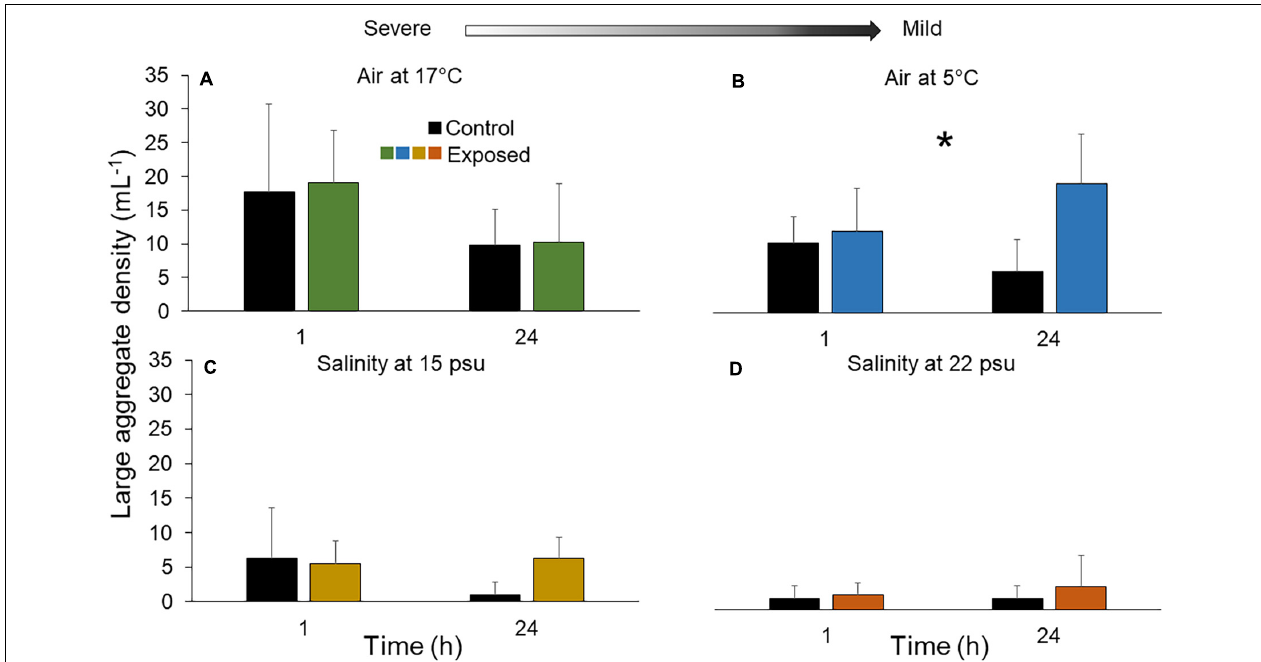
FIGURE 5 | Density of large aggregates in fluid of the Polian vesicle (mean ± SD, n = 5–10) after exposure of sea cucumbers to (A) 17 ◦ C air (B) 5 ◦ C air (C) 15 psu salinity and (D) 22 psu salinity. The asterisk (*) indicates significant differences within one treatment group ( p < 0.05), however, pairwise comparisons showed no statistical significance between control and exposed individuals at either time point (1 and 24 h). There was no statistical difference between treatment groups at different time points ( p > 0.05). Arrow indicates severe and mild stressors relative to the control. Measurements were made immediately after the exposure (1 h) and after a 23 h recovery period (total of 24 h). Main statistical results are shown in Supplementary Table 2